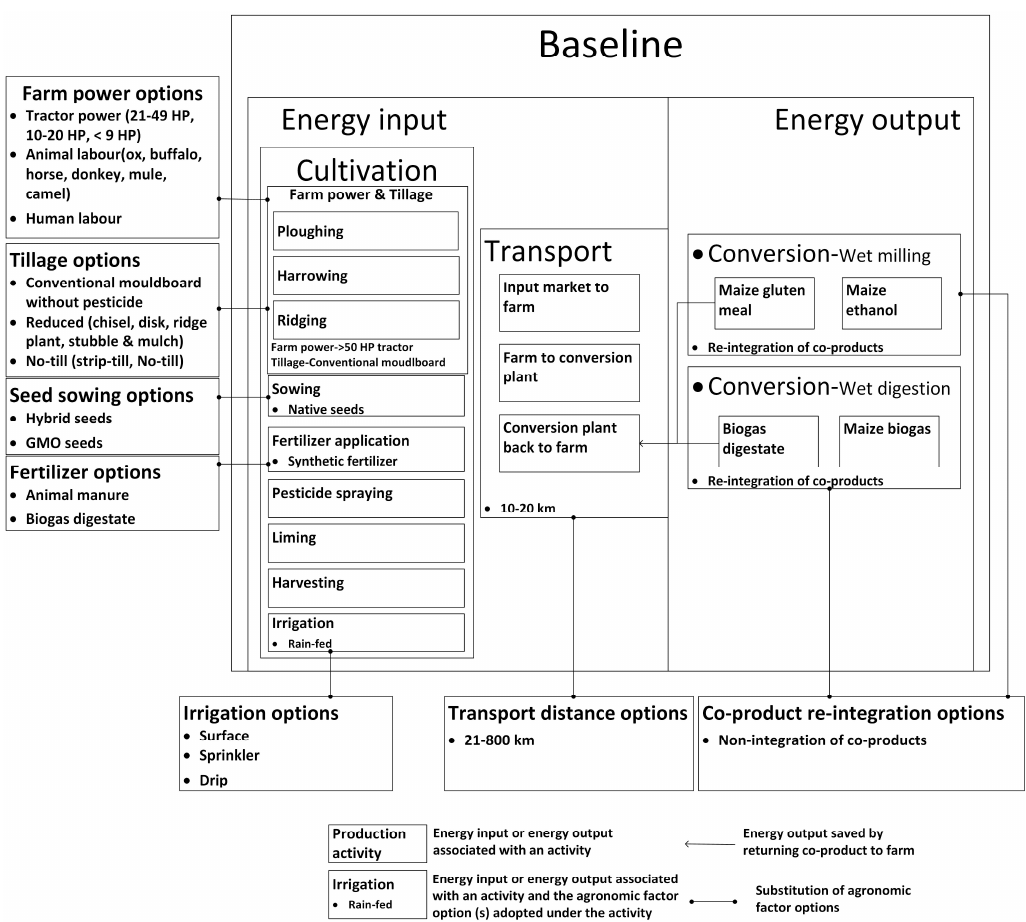
Figure 1. A graphical illustration of the methodological framework adopted by this